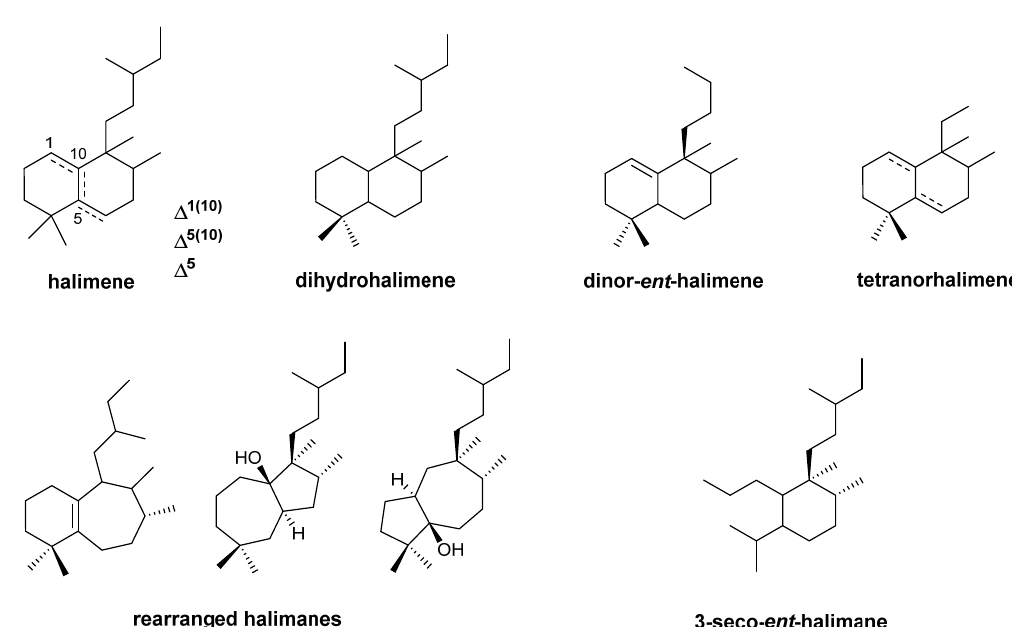
Figure 3. Some halimane skeletons.